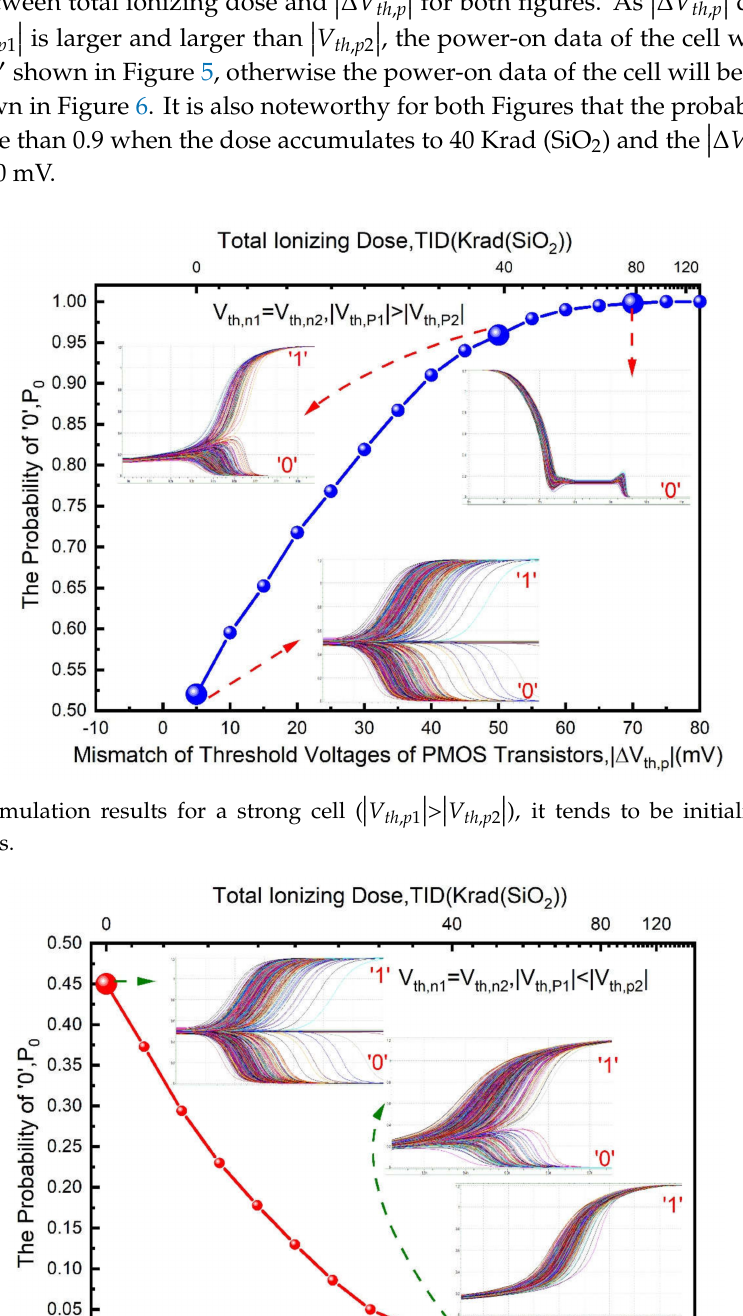
(cid:12) (cid:12) (cid:12) (cid:12) (cid:12) (cid:12) (cid:12) (cid:12) (cid:12) V th , p 2 (cid:12) ), it tends to be initialized to 1 as (cid:12) V th , p 1 (cid:12) <